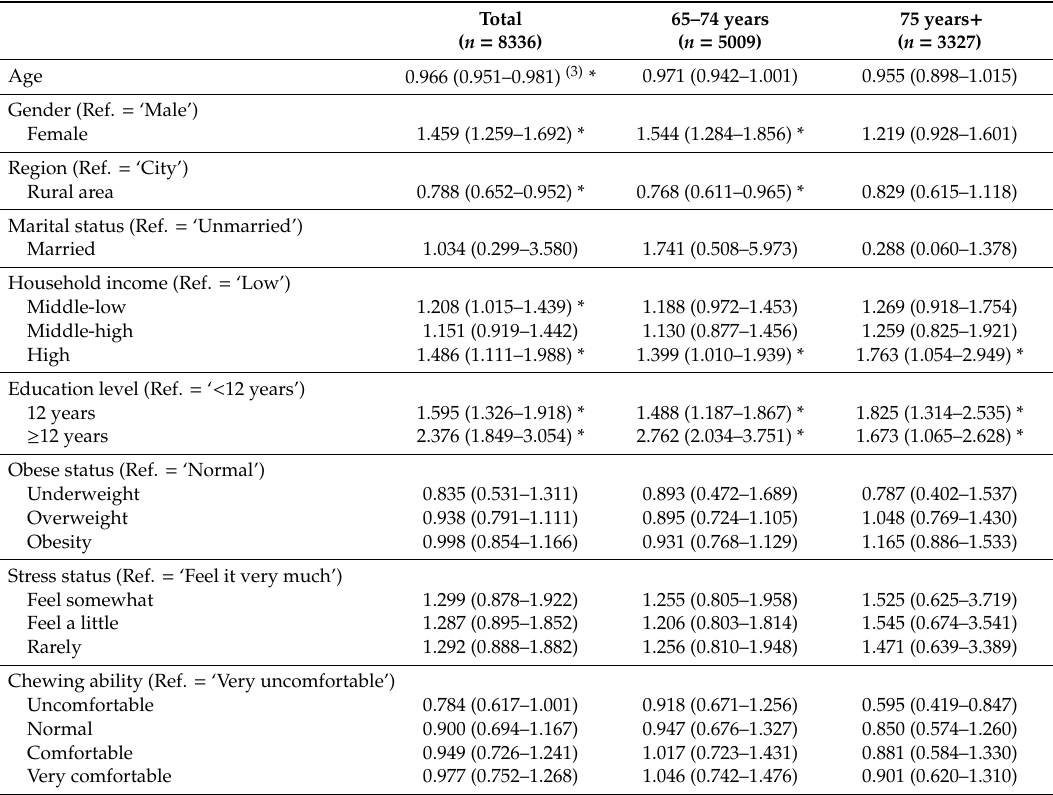
Table 6. Factors related to fruits and vegetables intake, general characteristics, and dietary behavior (1)(2)